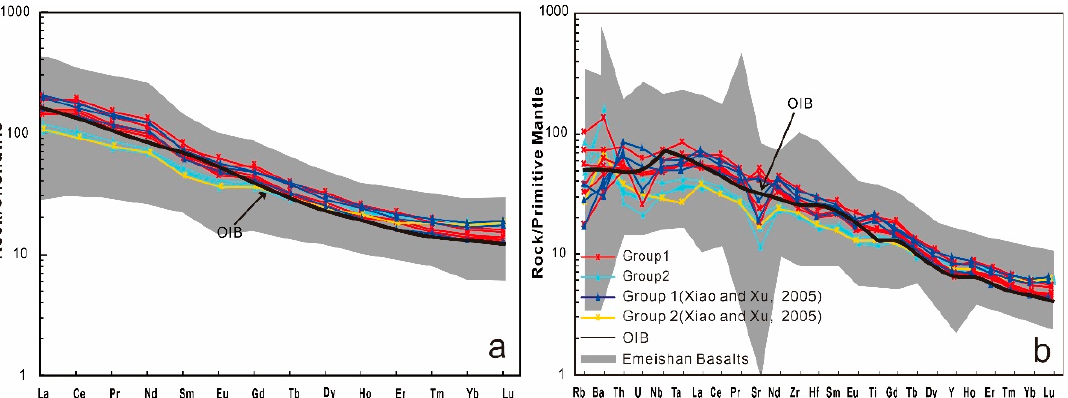
Figure 7. ( a ) Chondrite-normalized REE pattern distributions and ( b ) primitive-mantle-normalized trace element spider diagrams for Dashibao basalts in the Xindianzi area. Normalizing values for chondrite and primitive mantle are from [58], and the average composition of OIB is after [58]. Shaded areas are plotted Emeishan basalts [60].